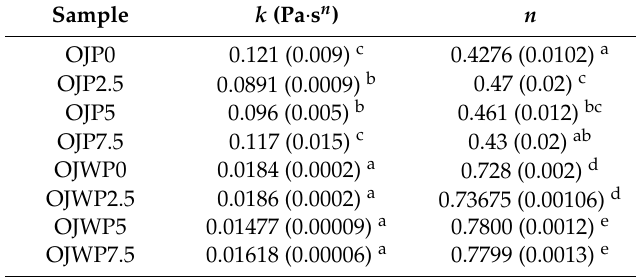
Table 3. Mean values (and standard deviations) of consistency index ( k ), flow index ( n ) of pasteurised orange